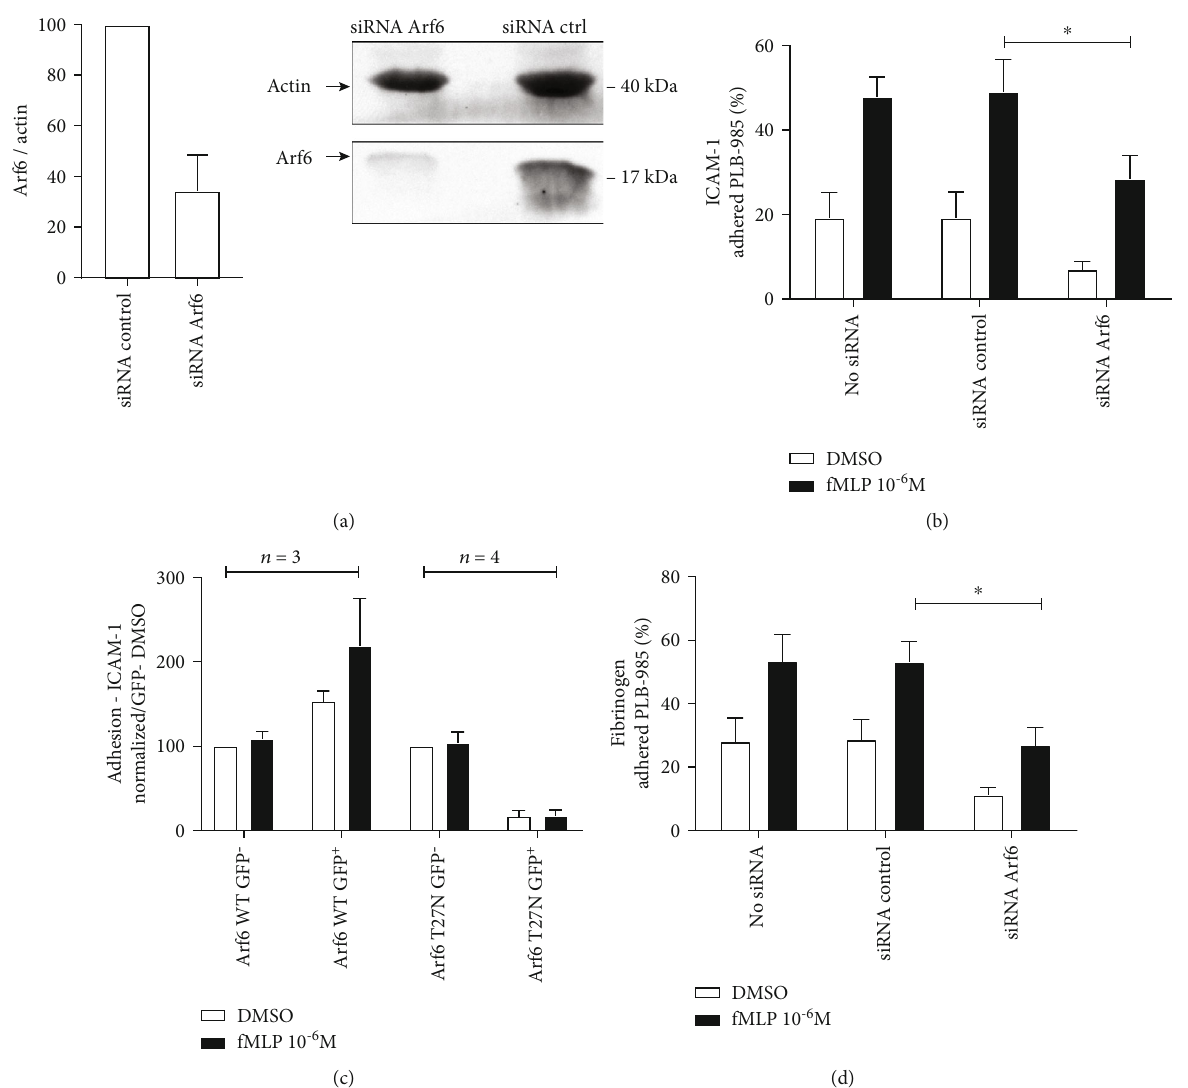
Figure 1: Arf6 regulates fMLP-induced PLB-985 adhesion to immobilized β 2 integrin ligands. (a) Arf6 siRNA and negative control siRNA were transfected into PLB-985 cells as described in Materials and Methods. Arf6 expression was analyzed 48h posttransfection by immunoblotting with anti-Arf6 and anti-actin (loading control) antibodies ( n = 3 independent experiments). The left panel is from one representative experiment. (b) PMN-like PLB-985 silenced or not for Arf6 (48 h) were labeled with calcein-AM and stimulated with fMLP for 30 min to promote adhesion to immobilized ICAM-1 ( n = 4 independent experiments performed in triplicate). (c) PMN-like PLB-985 were transfected with the various Arf6-GFP constructs for 48 h, GFP + and GFP - cells were sorted using GFP setting as previously described [23], and fMLP-mediated adhesion of calcein-labeled PMNs to ICAM-1 was evaluated ( n = 3 or 4 independent experiments performed in triplicate). (d) PMN-like PLB-985 were transfected with Arf6-speci fi c siRNA or siRNA control (48 h), were labeled with calcein-AM 30, and stimulated with fMLP for 30 min to promote adhesion to immobilized fi brinogen ( n = 4 independent experiments performed in